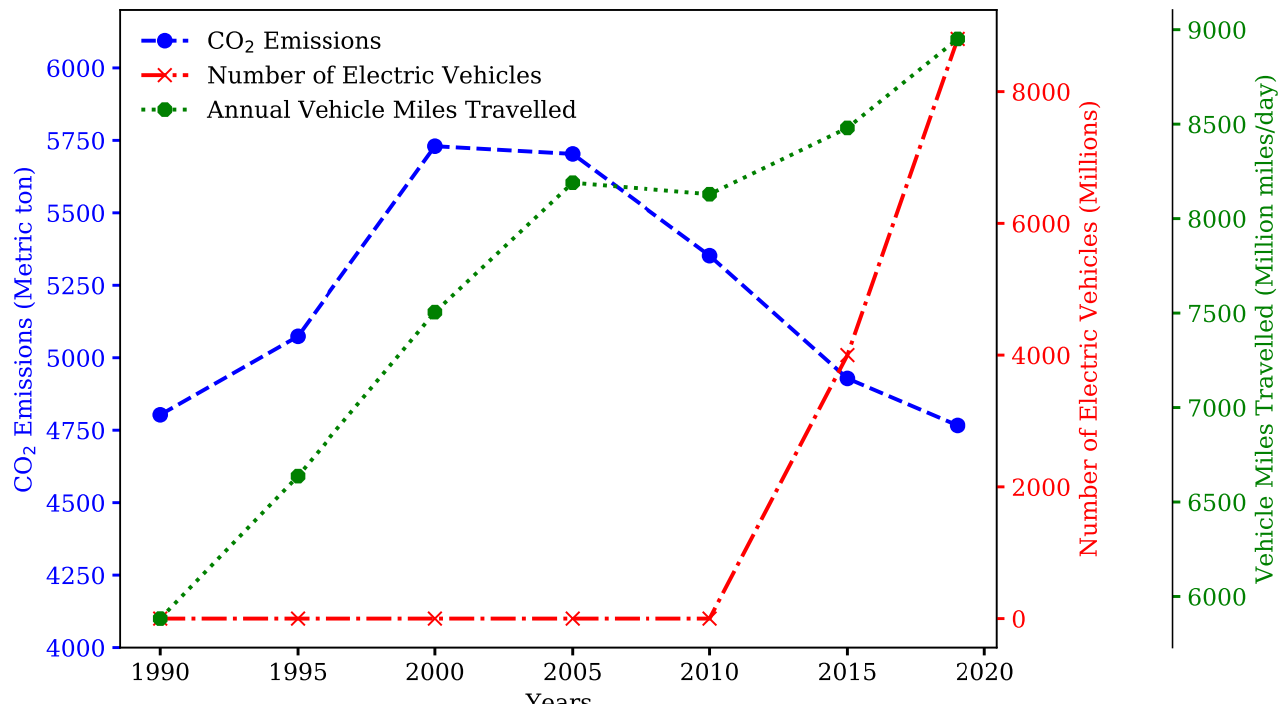
Figure 2. Impact of EVs and vehicle miles travelled on CO 2 emissions for 30-year period.